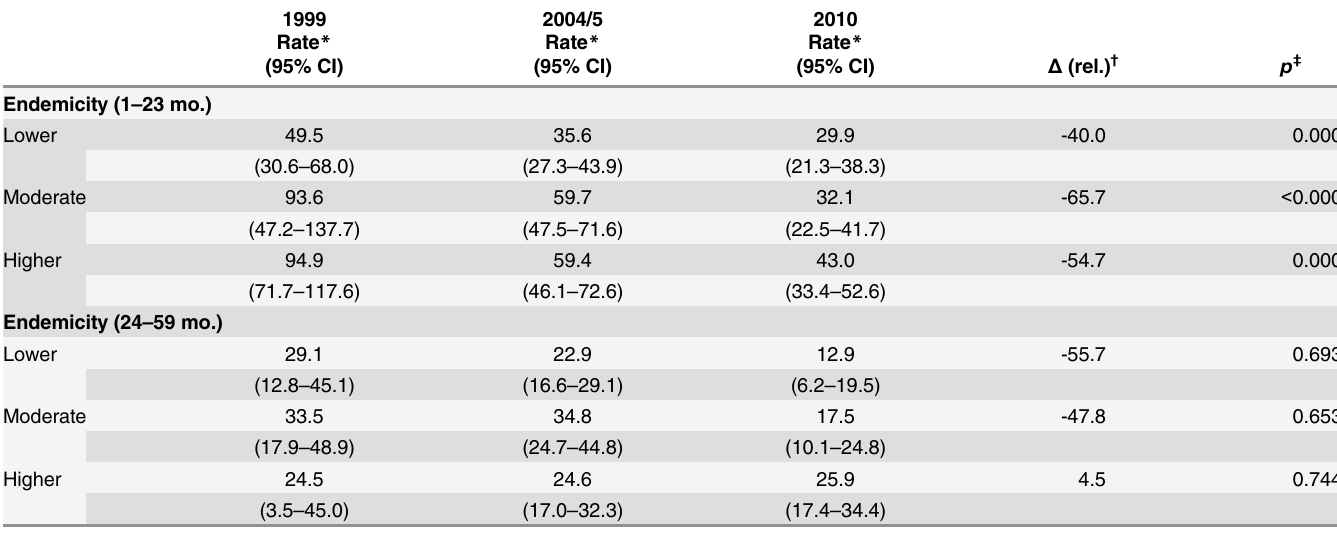
Table 3. All-cause mortality (1 – 59 months of age) stratified by malaria endemicity and age on Mainland Tanzania, 1999, 2004/5,